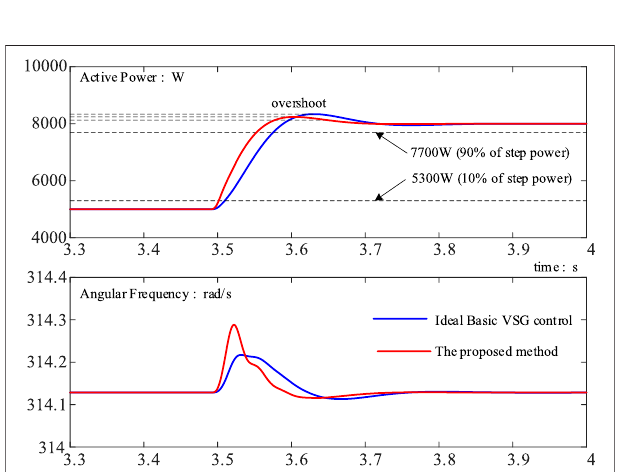
TABLE 2 | Parameters of the 5 kVA